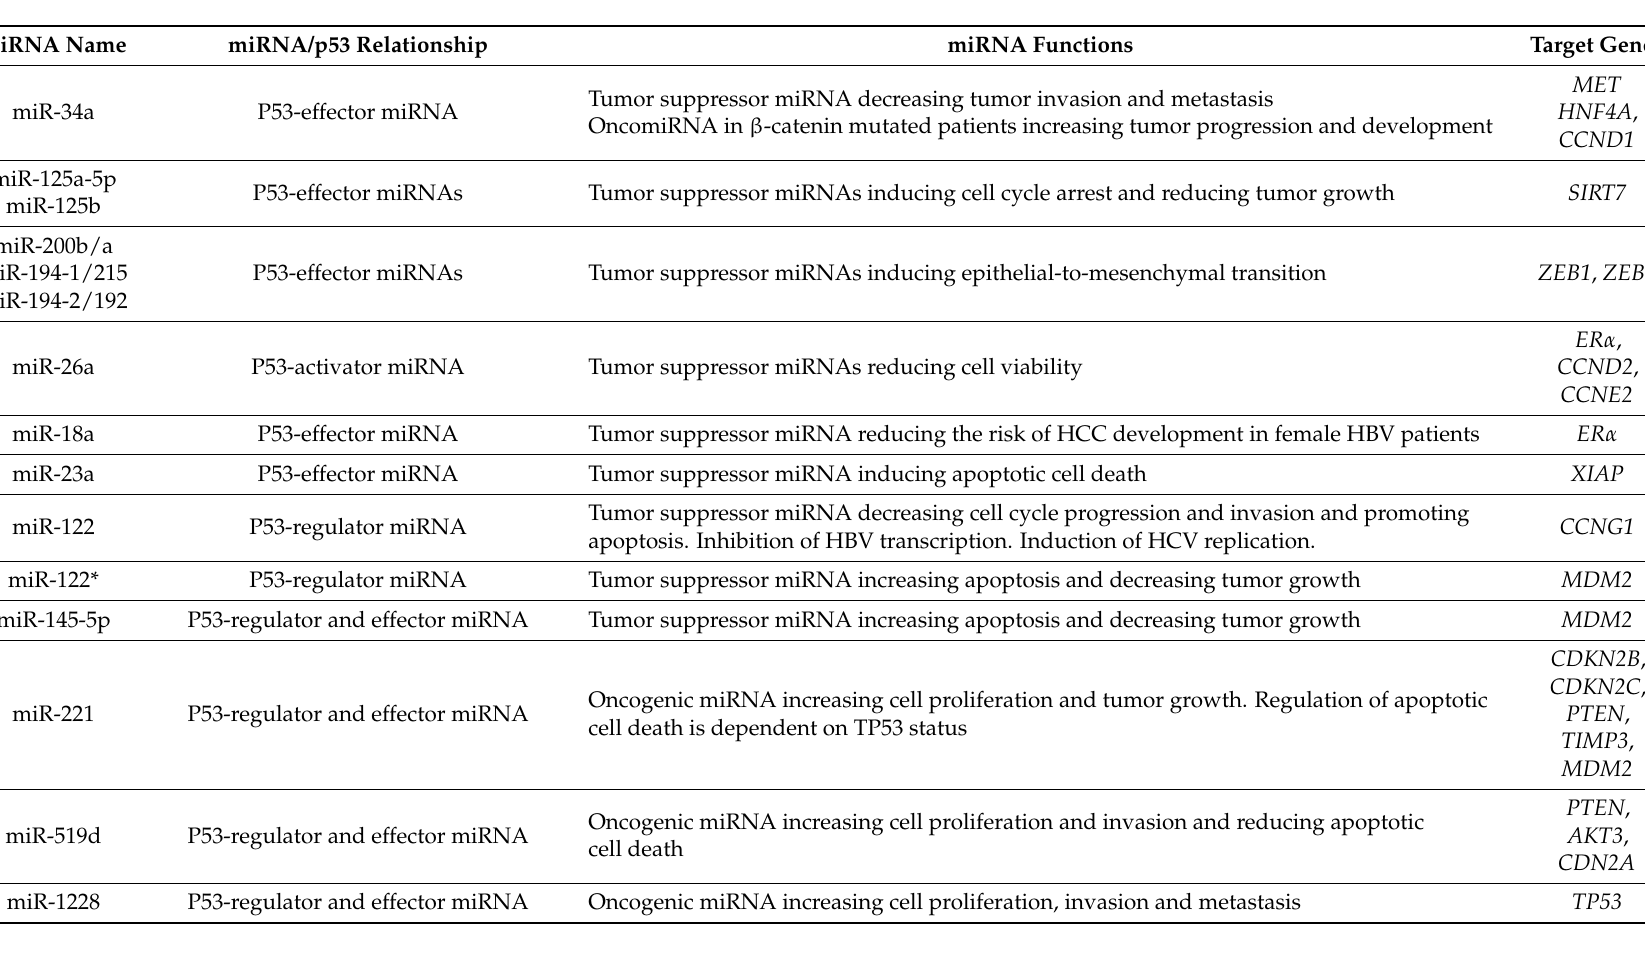
Table 1. List of HCC-specific miRNAs involved in p53-regulatory